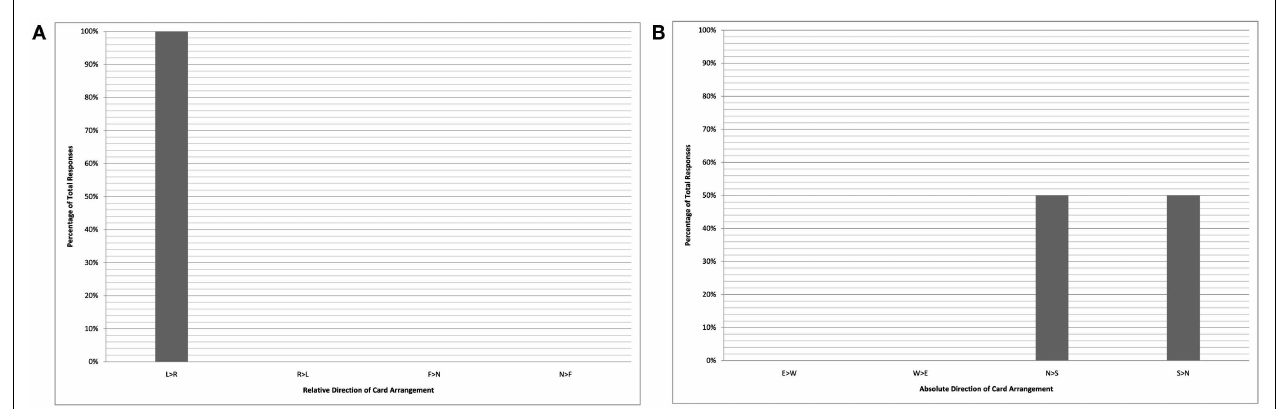
FIGURE 1 | English-monolinguals (card task). Chart shows relative coding of data (A) and absolute coding of data (B) . Key (A) : L > R “left-to-right”; R > L “right-to-left”; F > N “far-to-near”; N > F “near-to-far.” Key (B) : E > W “east-to-west”;W > E “west-to-east”; N > S “north-to-south”; S > N